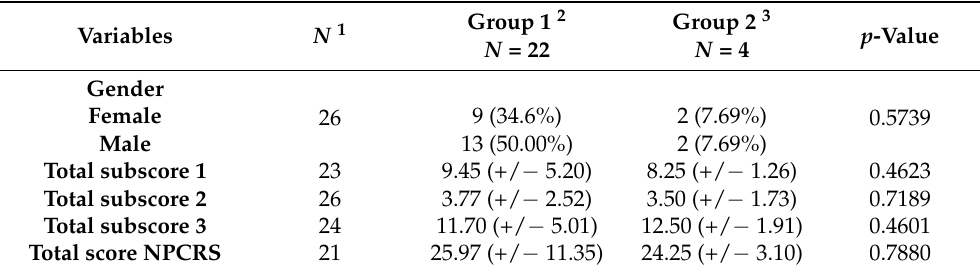
Table 2. Subscores and total Nijmegen score in patients with one non-functioning allele and patients with other nucleotide